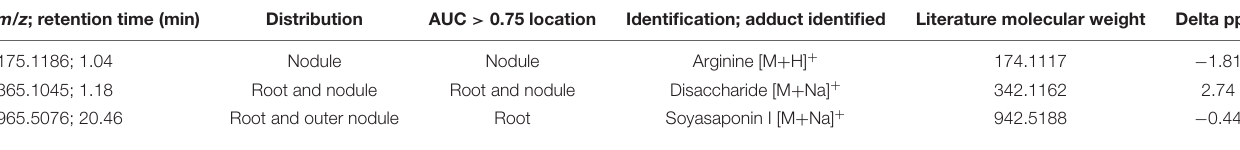
TABLE 2 | Identifications from salt treated roots and root nodules with AUC >